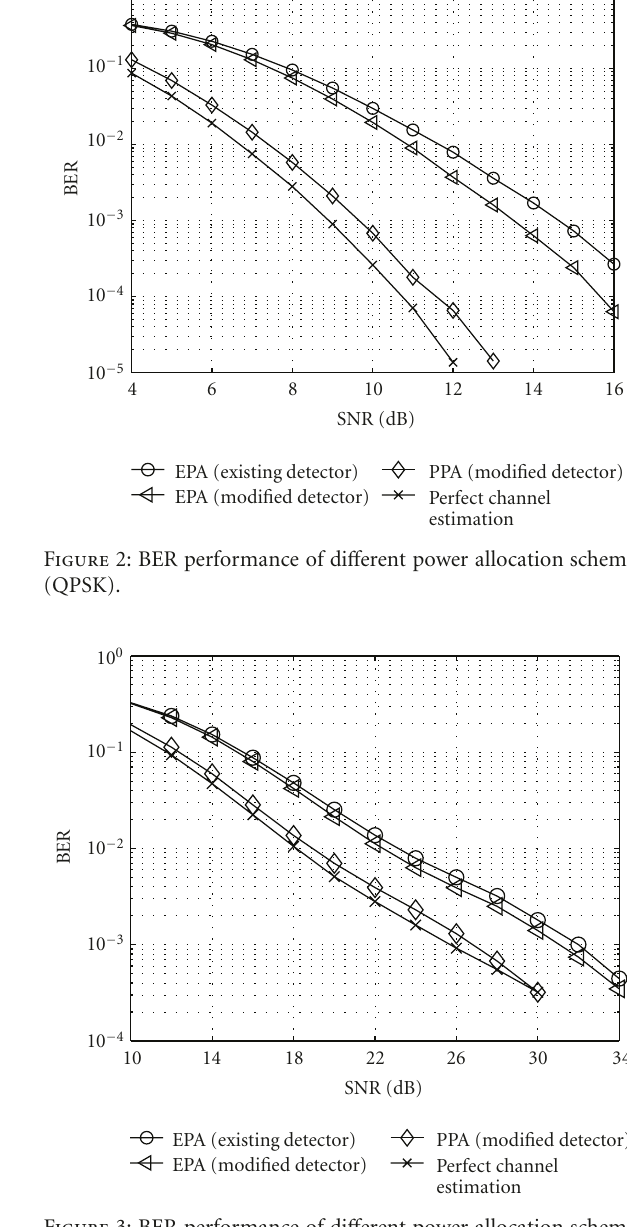
Figure 3: BER performance of di ff erent power allocation schemes